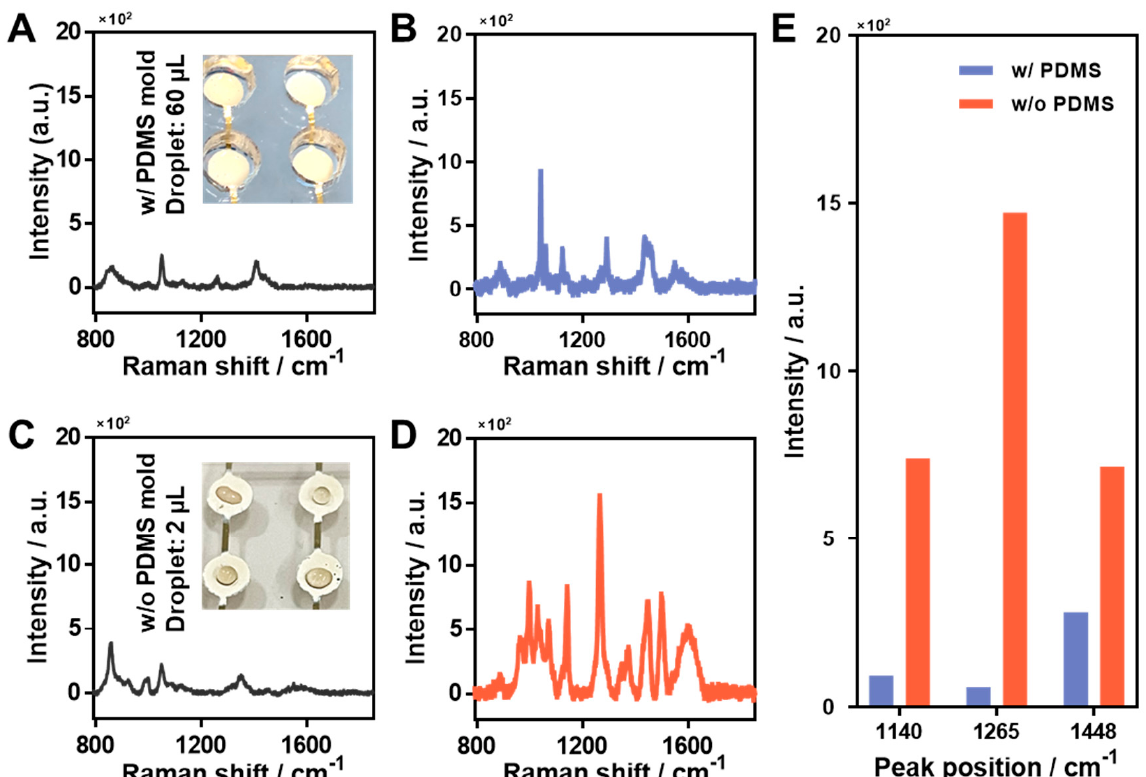
Figure 3. Optimization of sample preparation: sample treatment. The case of using a PDMS mold in the preparation process of ( A ) control solution and ( B ) CPF 1 µ M treated Ag-NG substrates. Without a PDMS mold: ( C ) control solution and ( D ) CPF 1 µ M treated Ag-NG using the direct-dropping method (single droplet: 2 µ L). The inset images are the optical images of each sample with and without a PDMS mold. ( E ) Comparison of the main characteristic peaks (1140, 1265, and 1448 cm − 1 ) of CPF according to the sample preparation condition with and without a PDMS